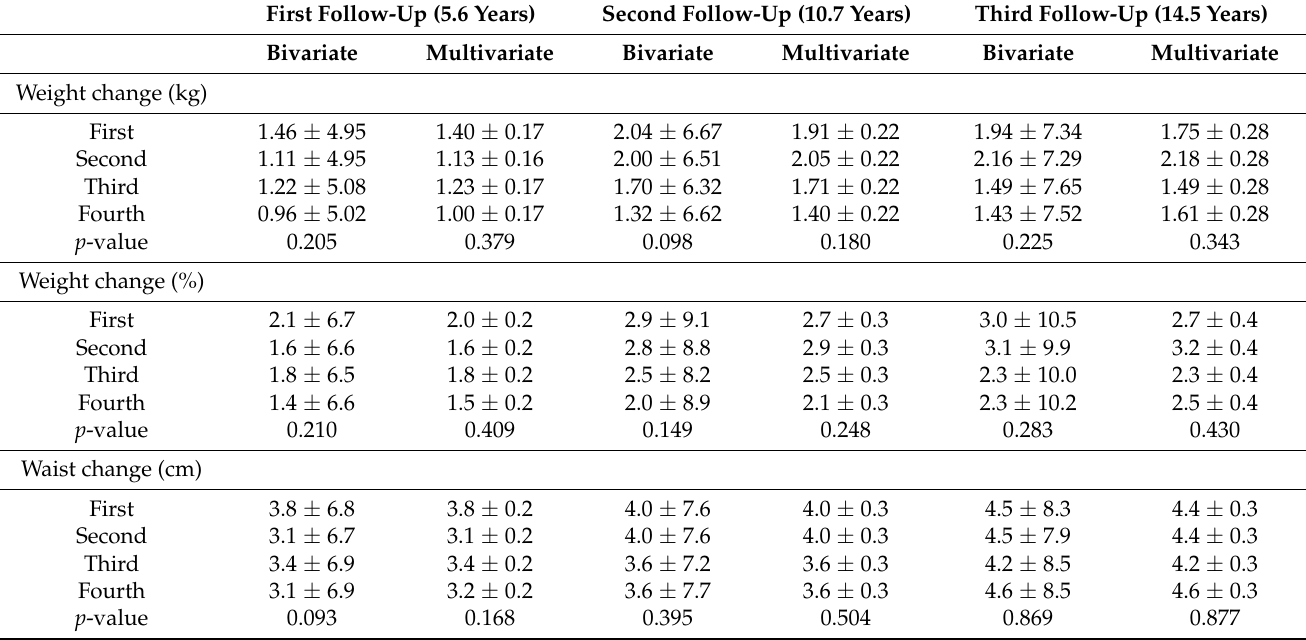
Table 1. Bivariate and multivariate analysis of 5-, 10-, and 15-year changes in weight according to quartiles of the genetic risk score for vitamin D, CoLaus study, Lausanne, Switzerland. First Follow-Up (5.6 Years) Second Follow-Up (10.7 Years) Third Follow-Up (14.5 Years) Bivariate Multivariate Bivariate Multivariate